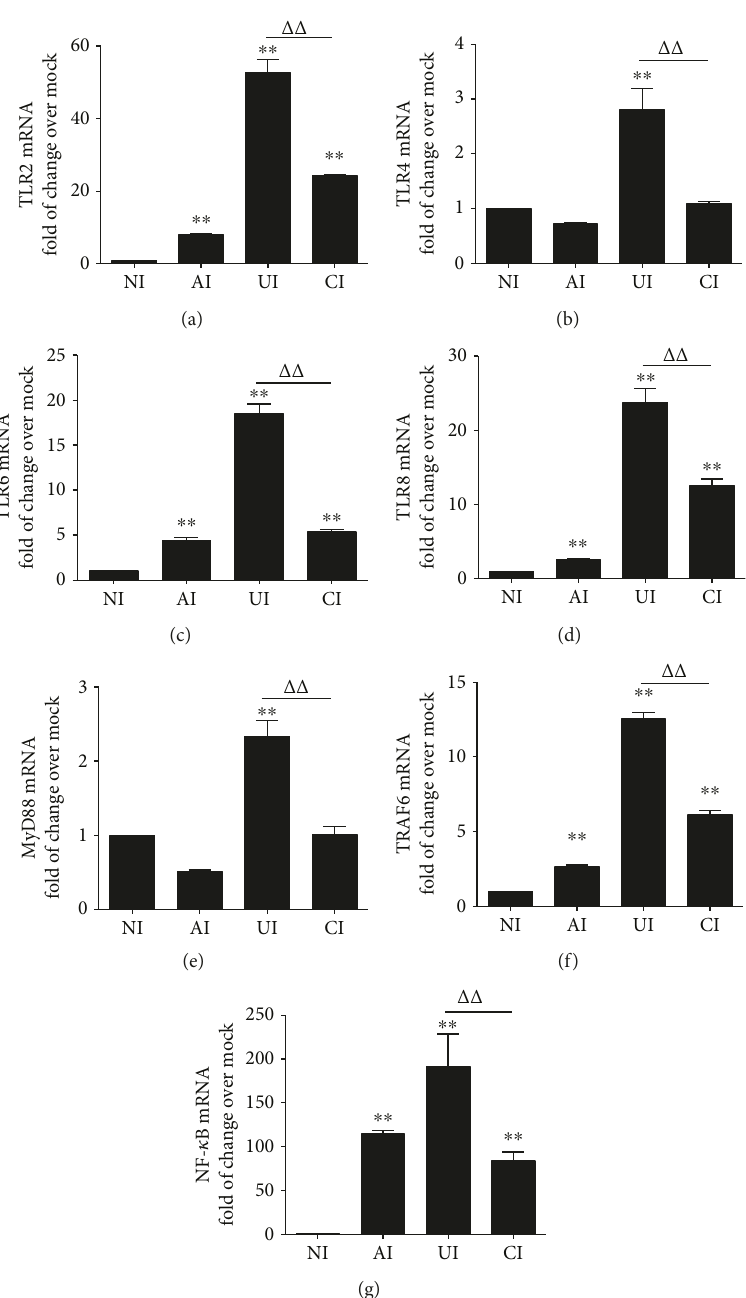
Figure 2: Mtb H37Rv-infected A549 cells inhibited the expression of TLR signaling of U937 cells in response to Mycobacteria infection. The coculture model of A549/U937 cells was infected with H37Rv Mycobacteria from the upper chamber (A549 cells, AI), lower chamber (U937 cells, UI), or both chambers (A549 and U937 cells, CI) at a MOI of 3 for 18 h before the U937 cells were harvested for analysis by RT-PCR assay. (a – g) Inductions of indicated transcripts of U937 cells infected with H37Rv in di ff erent conditions. (a) Fold of changes of TLR-2 transcripts over the noninfected cells; (B) fold of changes of TLR-4 transcripts over the noninfected cells; (c) fold of changes of TLR-6 transcripts over the noninfected cells; (d) fold of changes of TLR-8 transcripts over the noninfected cells; (e) fold of changes of MyD88 transcripts over the noninfected cells; (f) fold of changes of TRAF6 transcripts over the noninfected cells; (g) fold of changes of NF- κ B transcripts over the noninfected cells. Error bars represent the standard deviation (SD) from three independent experiments. Compared to noninfection (NI) control, ∗∗ p < 0 01 ; compared to infection of U937 cell alone, ΔΔ p < 0 01 . NI: noninfected control; AI: infection was performed on A549 cell alone; UI: infection was performed on U937 alone; CI: infection was performed on both A549 cells and U937